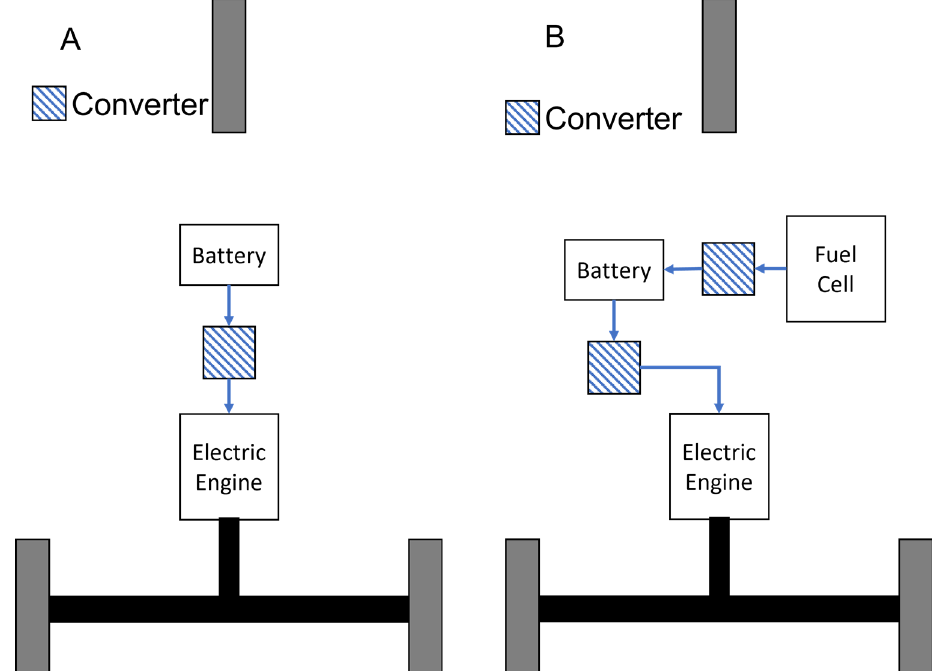
Figure 1. Schematic architecture of a battery scooter compared to a hydrogen cell scooter. By Author. ( A ) Schematic architecture of a scooter using a battery. ( B ) Schematic architecture of a scooter using a fuel cell.